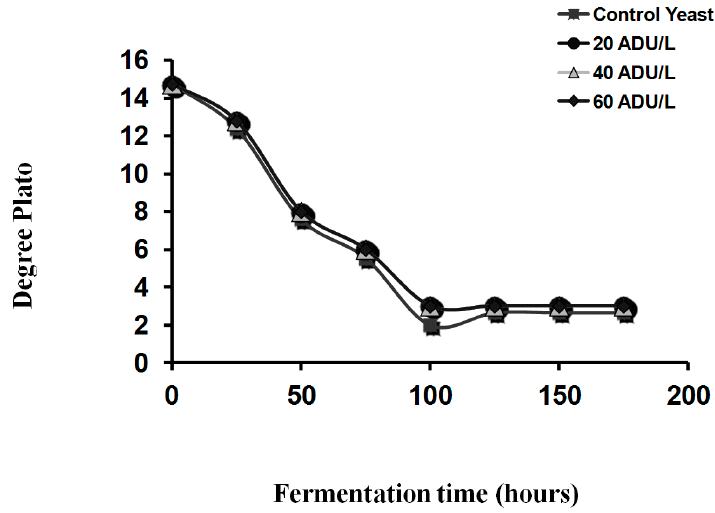
Figure 17. Effect of α -acetolactate decarboxylase (ALDC) on wort fermentation rate and extent [112].